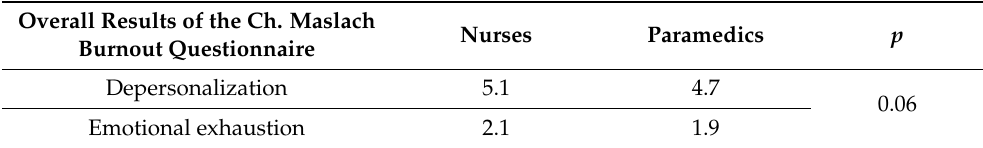
Table 7. The relationship between emotional exhaustion, depersonalization, and occupation of the study groups.